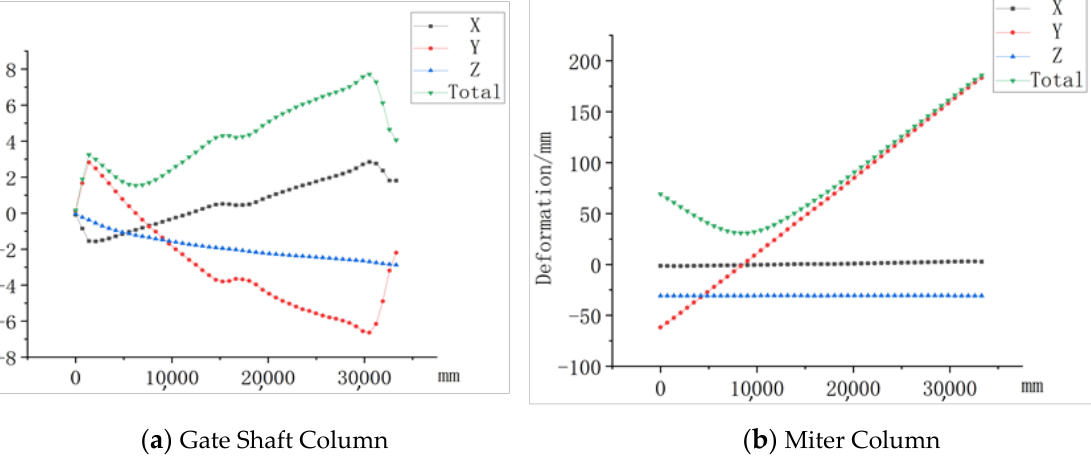
Figure 9. ( a ) Deformation of the gate shaft column, ( b ) Deformation of the miter column without the back tie rod at different directions under self-weight.